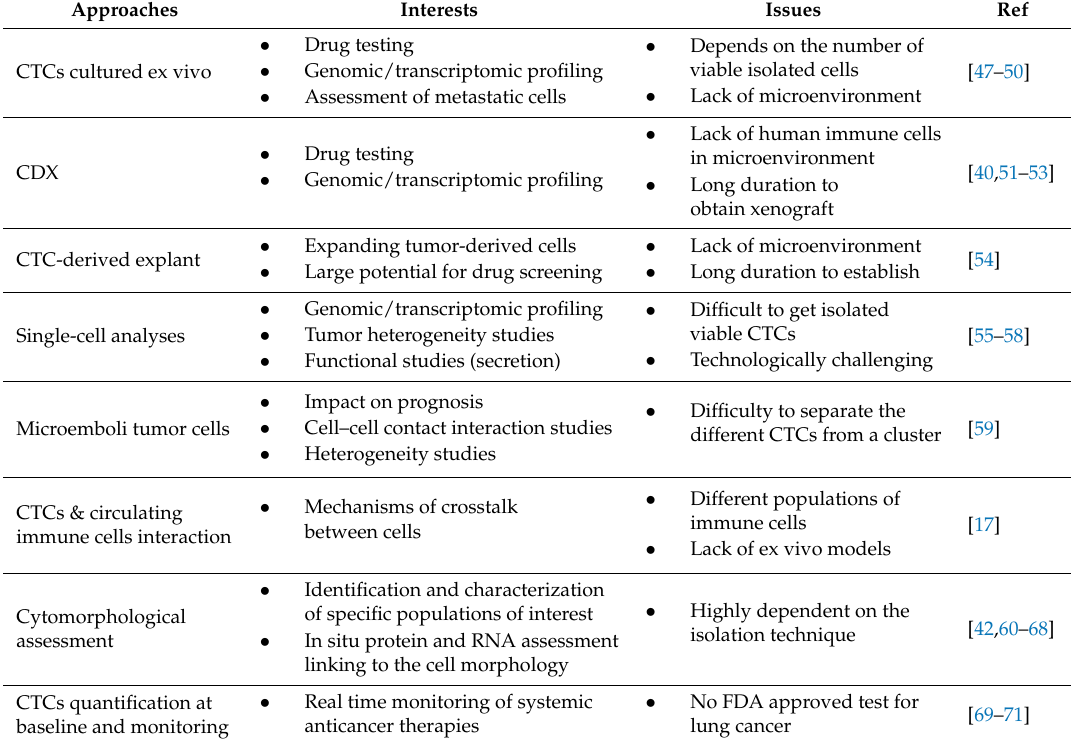
Table 2. Methodological approaches in CTC research and main